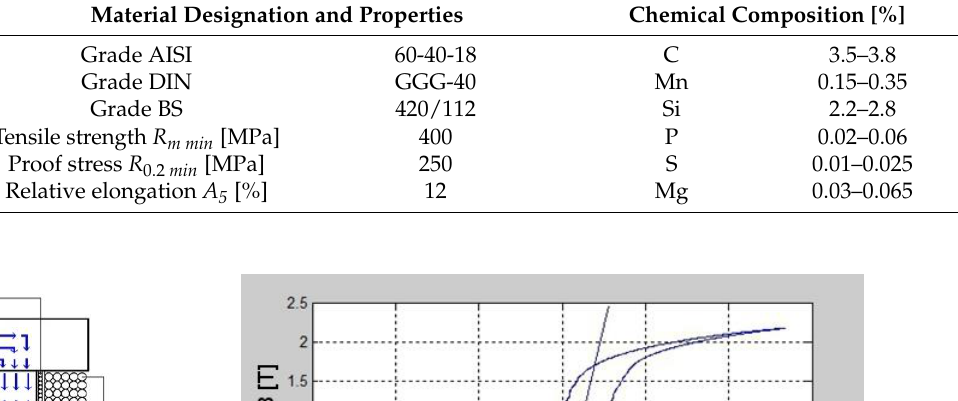
Table 1. Material designation, properties, and chemical composition of nodular cast iron alloy AISI 60-40-18 [20].